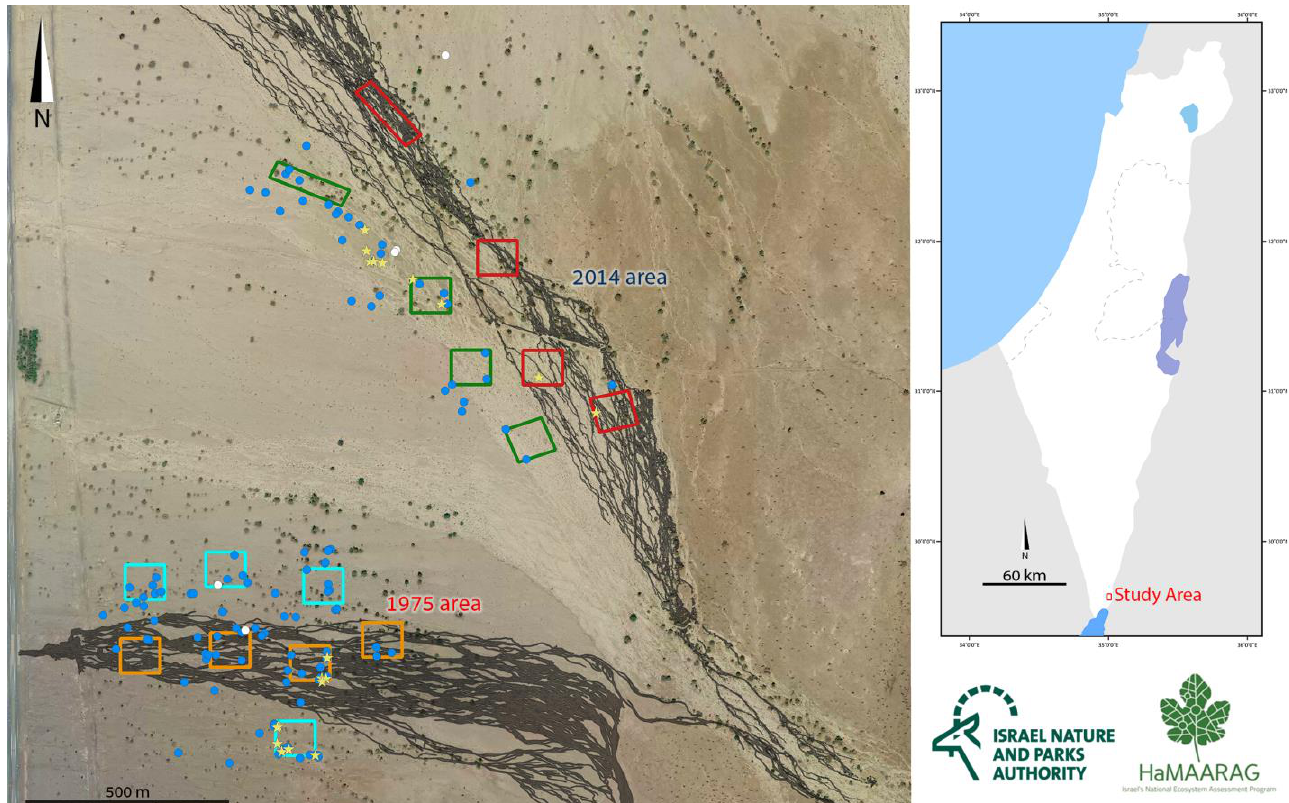
Figure 1. The study area with the 2014 and 1975 oil spill areas are marked in black. Rectangles designate monitoring plots: 2014 oil-contaminated plots in red, 2014 uncontaminated clean soil (control) plots in green, 1975 oil-contaminated plots in orange, 1975 uncontaminated clean soil (control) plots in turquoise. Dots and stars designate Sahastata burrows: burrows found in the first year of monitoring (2016) in white, burrows found after 2016 in blue, yellow stars designate burrows used for the quadrate survey.